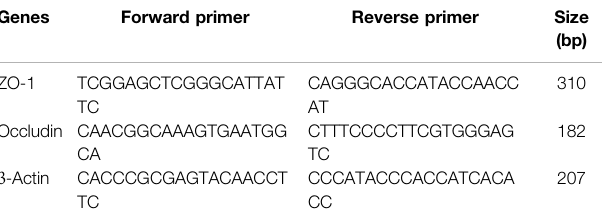
TABLE 1 | Primers sequences used for real-time